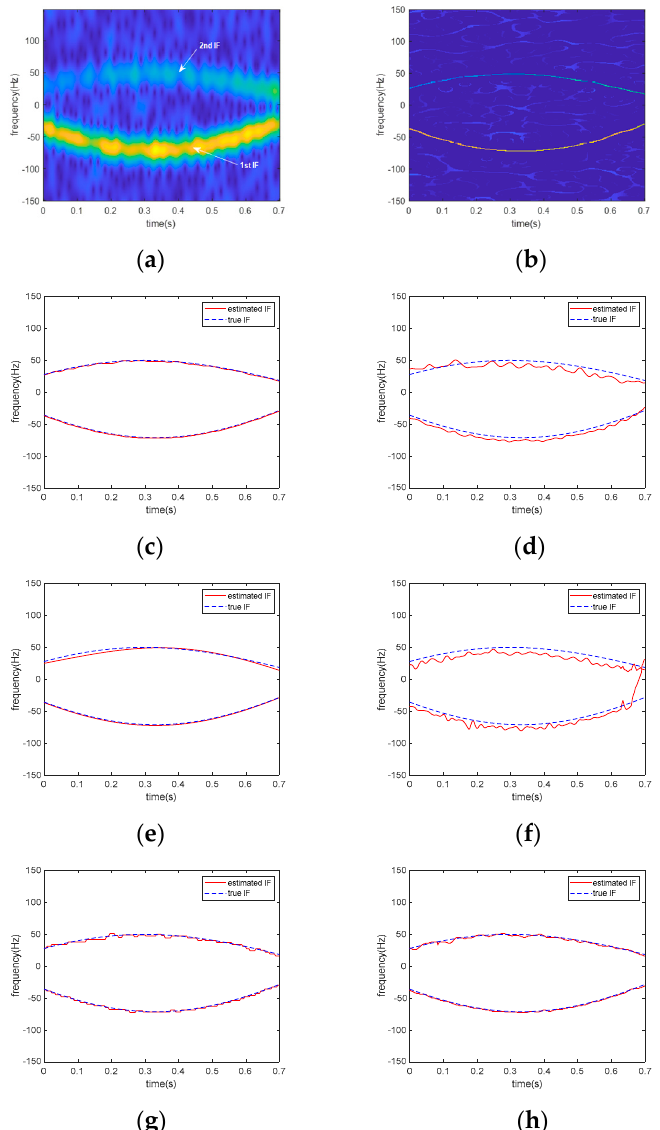
Figure 5. TF spectrums and IF estimation results for example 1 with SNR = 5 dB. ( a ) TF spectrum acquired by STFT; ( b ) TF spectrum acquired by SET. ( c ) MKF; ( d ) MTT; ( e ) CSRDI-MGPTF; ( f ) ACO; ( g ) MD-STFT; ( h ) MD-SET. Table 2. Performance evaluation of IF Estimation for example 1 based on the relative root mean squared error (RRMSE), the mean absolute error (MAE) and the determination coe ffi cient ( R 2 ). Method MKF MTT